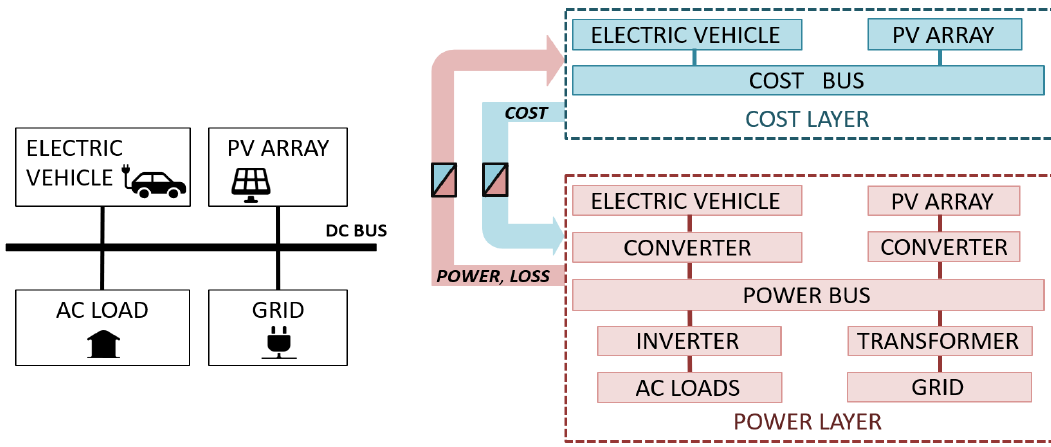
Figure 14. Structure of the EES case study 2 ( left ) and result of the application of the proposed approach ( right